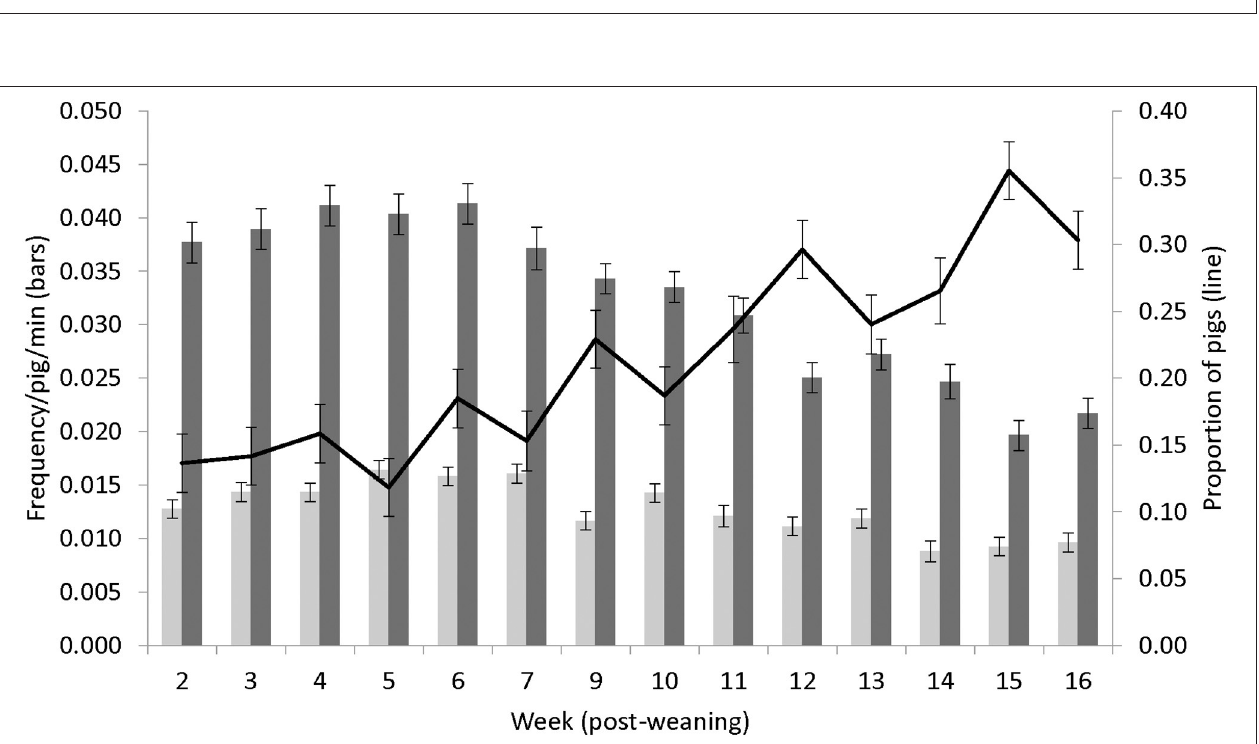
FIGURE 5 | Mean ( ± s.e.) activity level over time based on (A) all behaviors combined (damaging + positive behaviors, see Table 3 for full ethogram, light gray bars, as frequency/pig/min) (B) total enrichment interactions (dark gray bars, as frequency/pig/min) and (C) proportion of pigs lying inactively (black line).